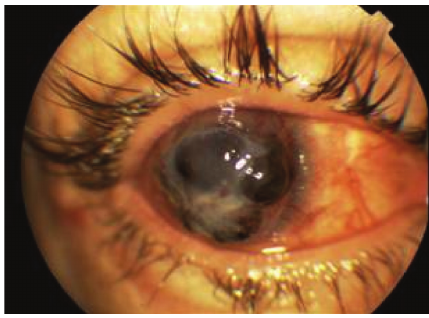
Figure 5: Severe iris prolapse and corneal melting of the right eye after second amniotic membrane transplantation.